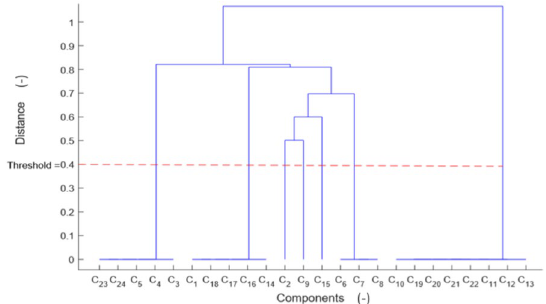
Figure 7 Results of component clustering